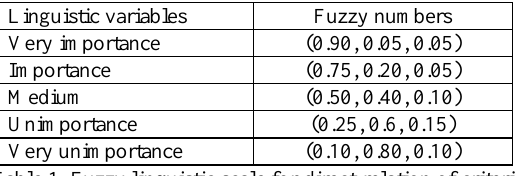
Table 1. Fuzzy linguistic scale for direct-relation of criteria Final weights of the criteria were computed according to the Table 2 and Table 3: